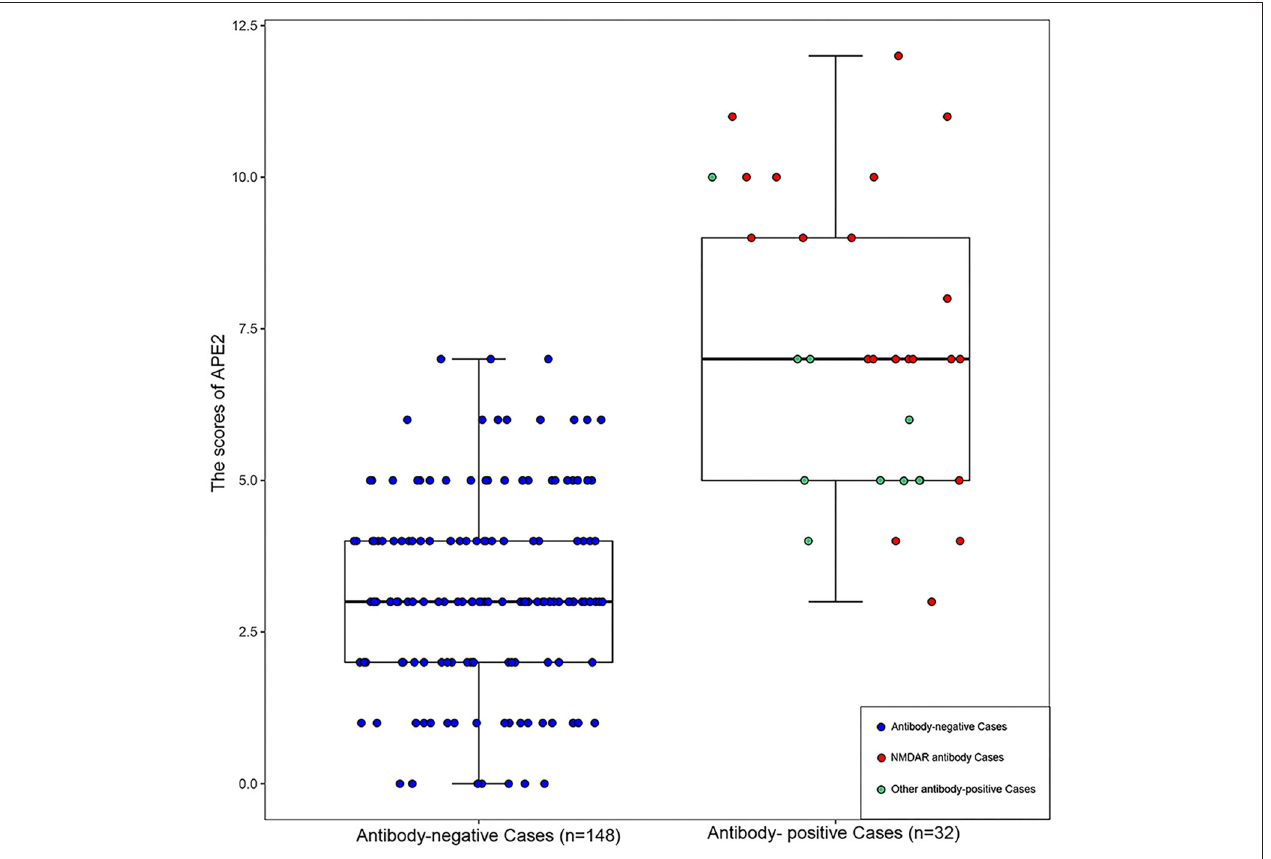
FIGURE 2 | The scores distribution of APE 2 in each patient. NMDAR antibody cases: n = 23; other antibody-positive cases including LGI1 ( n = 3), GABABR ( n = 3), CASPR2 ( n = 2), and AMPA1 ( n =